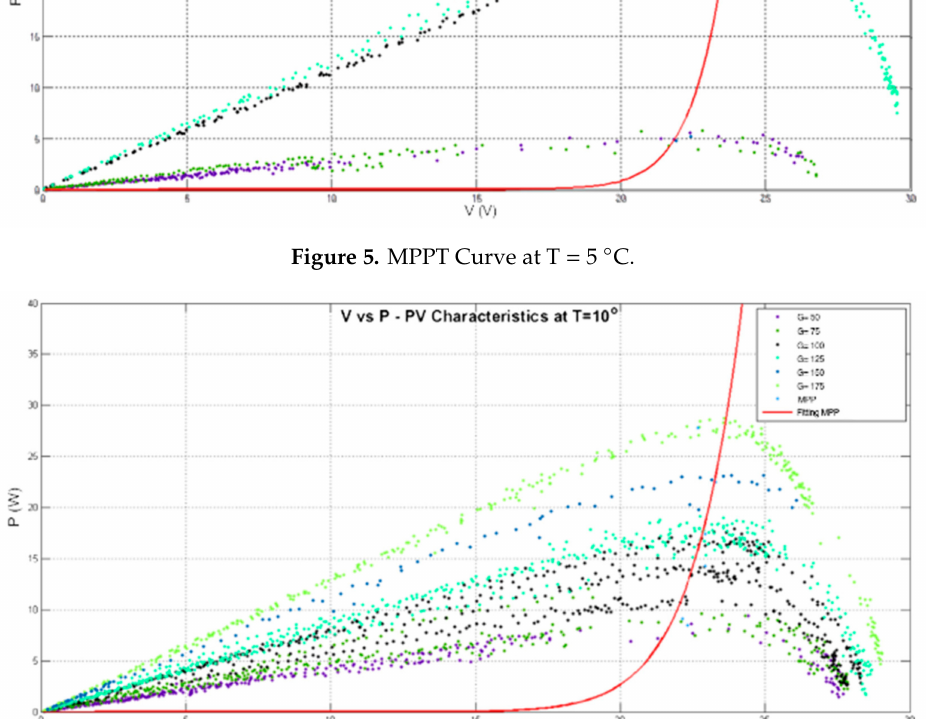
Figure 6. MPPT Curve at T = 10 ◦